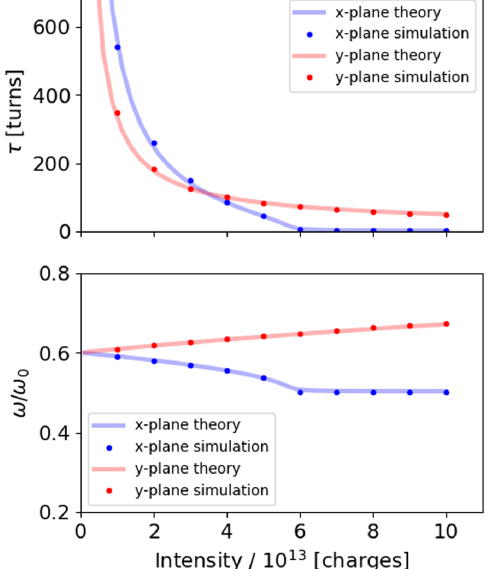
6. P y HEADTAIL simulations (with dots) compared to theory accounting for coupling between fast and slow waves (with full lines) for the horizontal (blue) and the vertical (red) planes. The rise time, at the top, and the normalized frequency shift, at the bottom, are